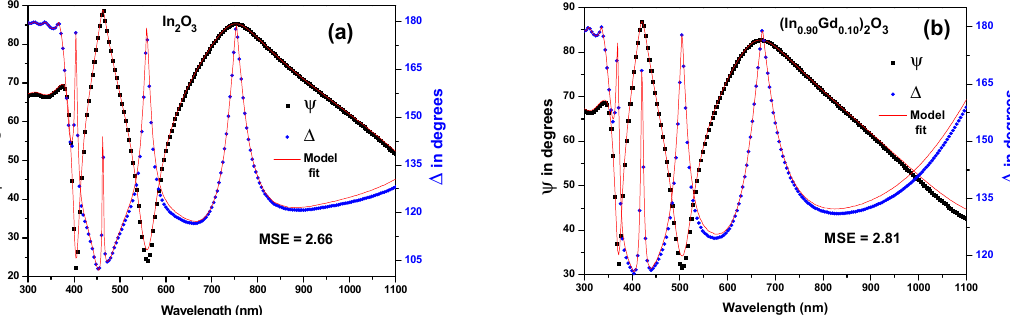
Figure 7. Ellipsometric parameters ( a ) ψ and ( b ) Δ versus wavelength for (In 1 − x Gd x ) 2 O 3 thin films. Figure 8a,b depicts the modeled spectrum dependency of ψ and Δ for (In 0.90 Gd 0.10 ) 2 O 3 films and it shows a superior fit with the measured data (symbols) acquired across the whole range. The average thickness for all films is 200 ± 1.23 nm, while the average surface roughness is 5.67 ± 0.13 nm. Surface roughness obtained through SE can match that of a standard 3D dimensional AFM scan image in terms of quality. More information on SE execution and its conceptual B-spline optical model is available in reference [23].